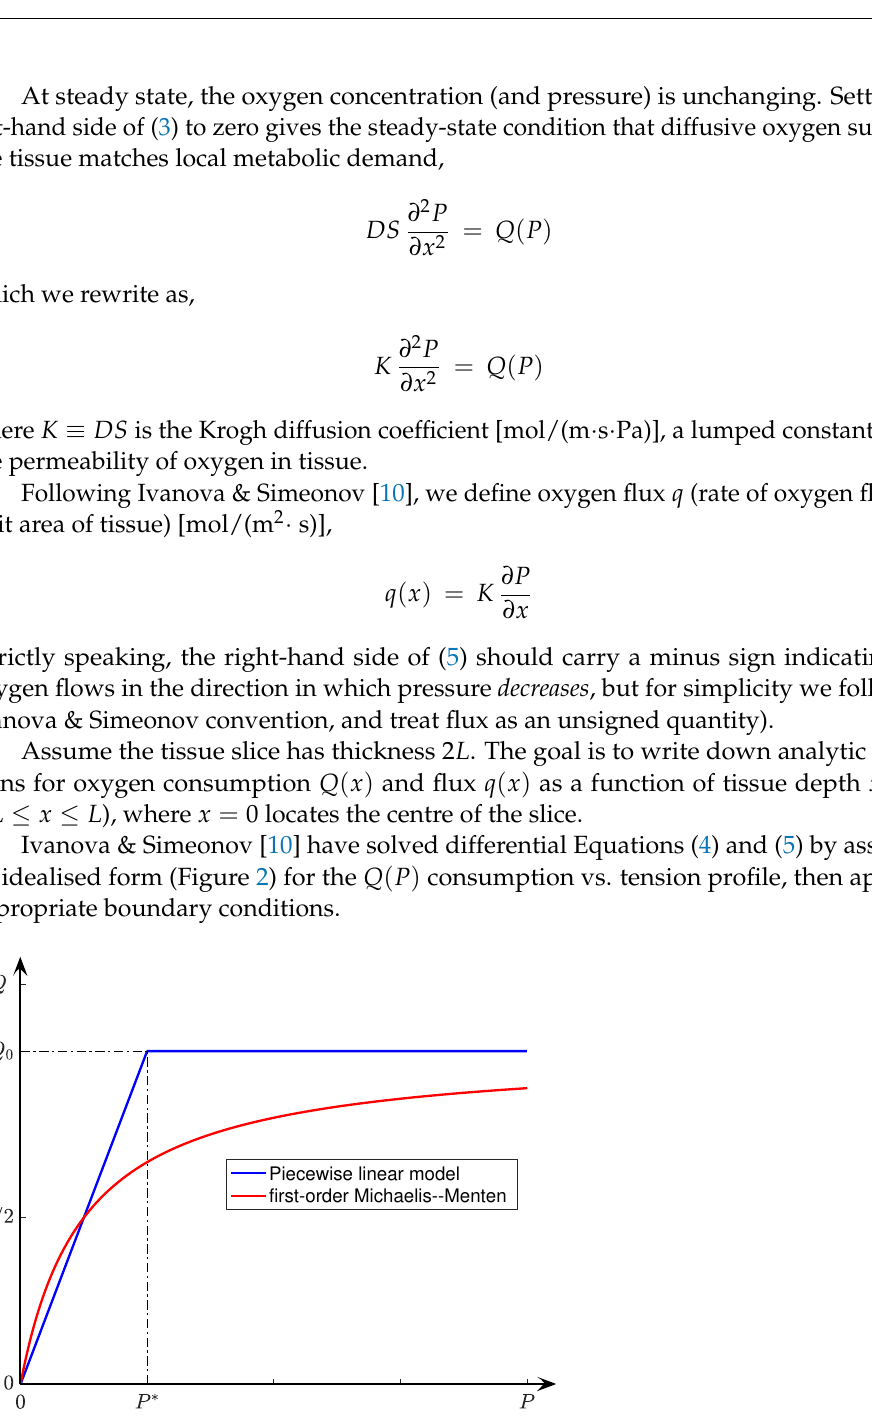
Figure 2. Two models for oxygen consumption rate in tissue as a function of oxygen tension. Ivanova and Simeonov’s piecewise-linear model of Equation (6) (blue curve) approximates the first-order Michaelis–Menton form Q ( P ) = Q 0 P / ( K M + P ) with Michaelis constant K M = P ∗ /2 (red